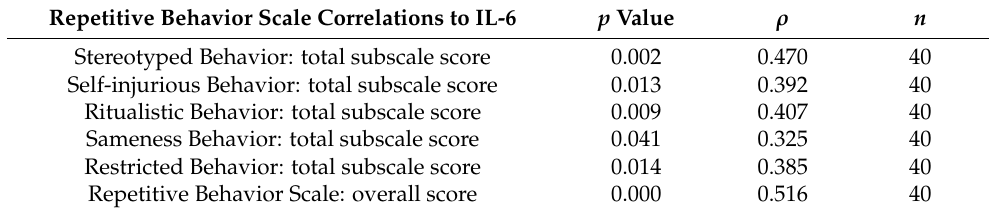
Table 2. Repetitive behavior scale correlations to LPS-induced IL-6 responses. Spearman’s rank correlation analysis identified significant correlations between IL-6 levels and Repetitive Behavior Scale scores. Increased RBS score indicates worsening behavior. ρ = Spearman’s